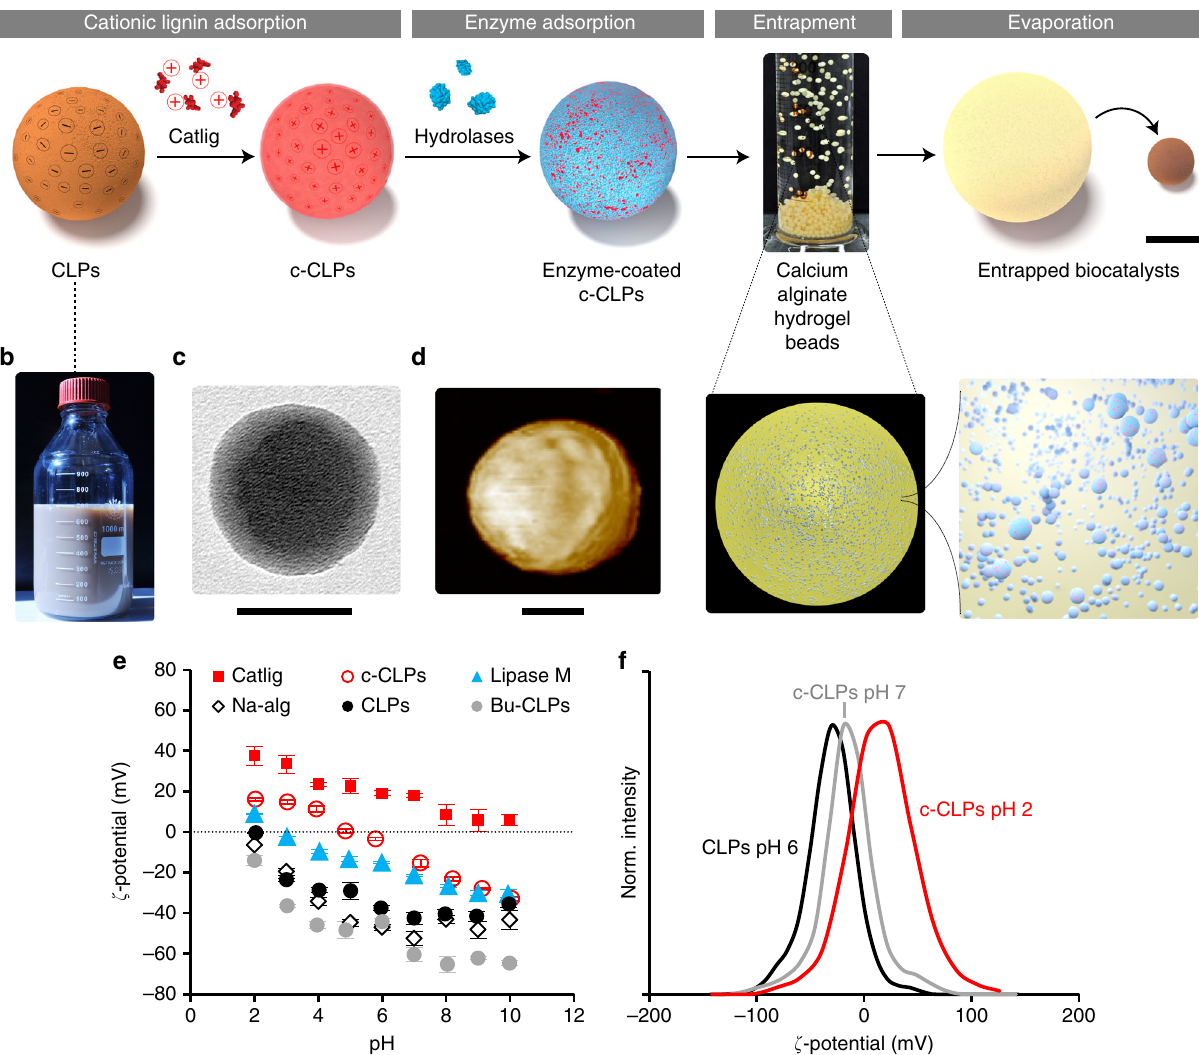
Fig. 1 Spatial con fi nement of enzymes utilizing colloidal lignin particles. a Scheme of the enzyme immobilization process comprising (i) Adsorption of cationic lignin on CLPs to yield c-CLPs. (ii) Adsorption of hydrolases on c-CLPs. (iii) Entrapment of enzyme-c-CLP complexes in calcium alginate hydrogel, and (iv) Consolidation of the alginate beads by evaporation of water under ambient conditions. b Photographic, c TEM, and d AFM images of CLPs. Scale bars: a = 1 mm, c , d = 50 nm. e ζ -potentials of the biomaterials as a function of pH. Error bars represent two standard deviations from the mean values (three measurements on a single replicate, except for Catlig six measurements on two replicates). f ζ -potential distributions of CLPs and